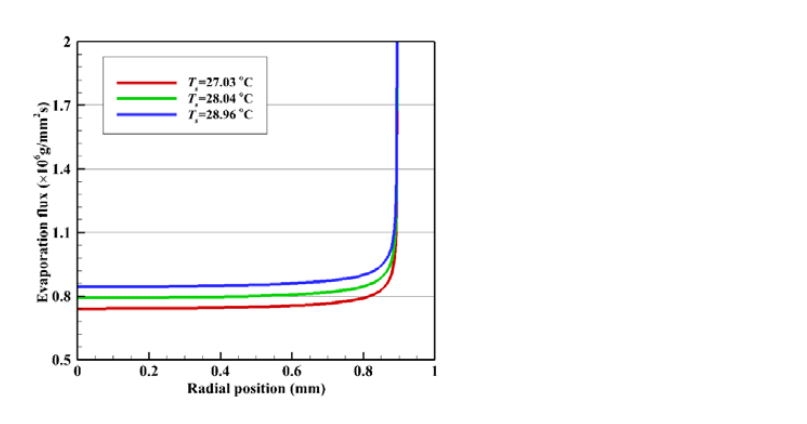
Figure 7. Theoretical evaporation flux of the droplet according to the surface temperature.